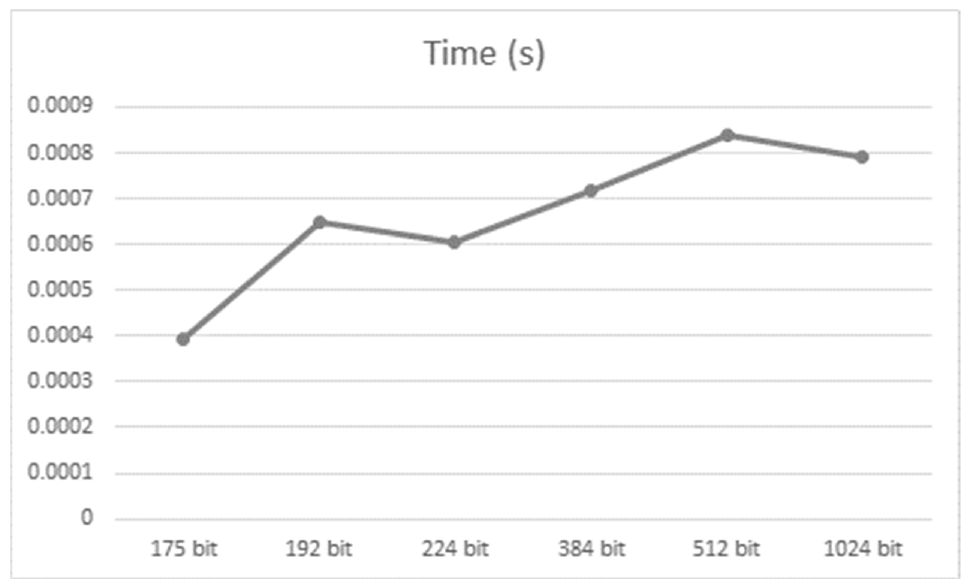
Figure 7. Execution times for encryption.